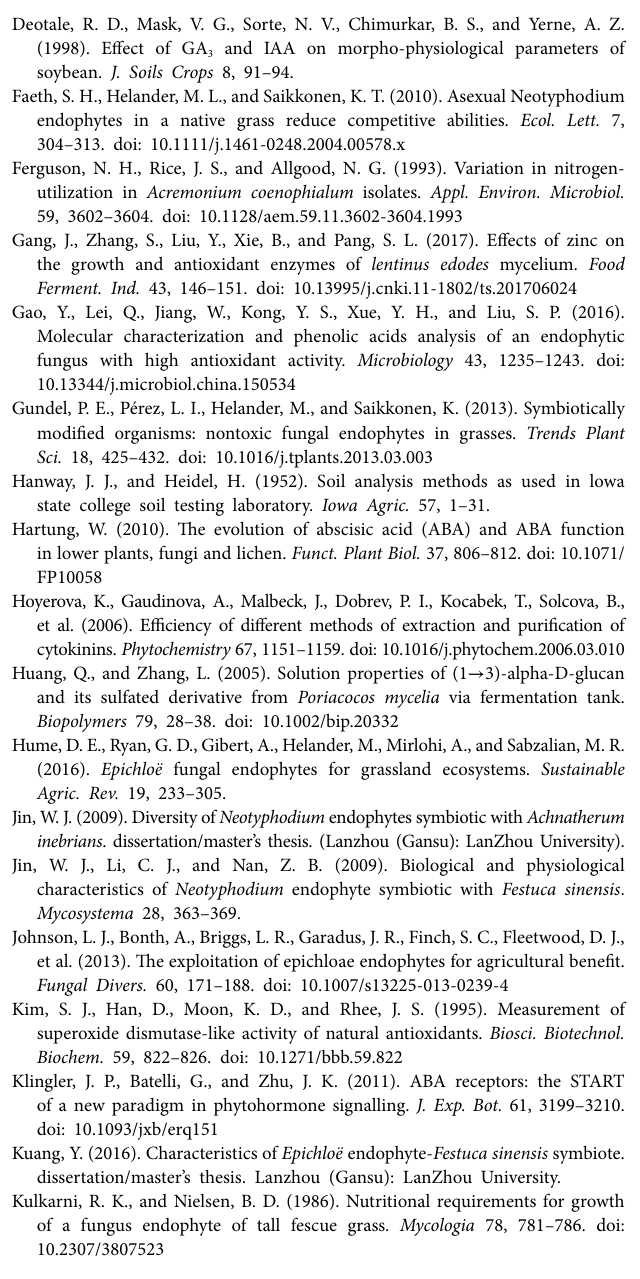
Supplementary Table S1 | Univariate analysis of general linear models was employed to estimate the effects of single factor and their interaction on